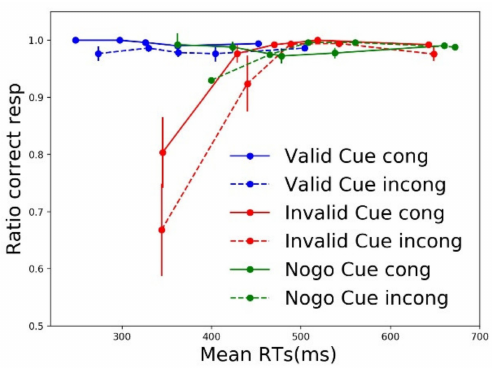
Figure 4. Conditional accuracy function. The ratio of correct responses is plotted as a function of RTs, divided in quintiles separately for each cue and compatibility condition. Error bars represent the standard